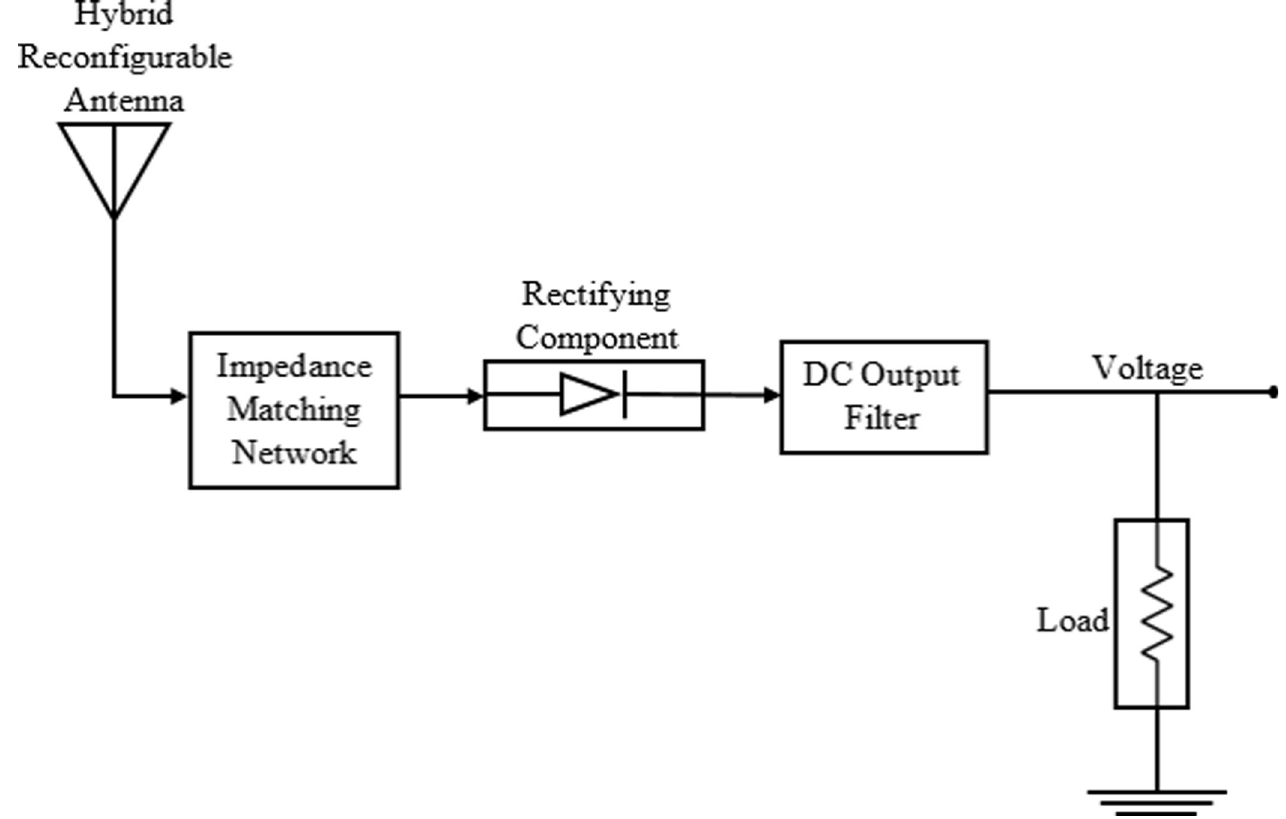
Fig 1. General block diagram of a hybrid reconfigurable